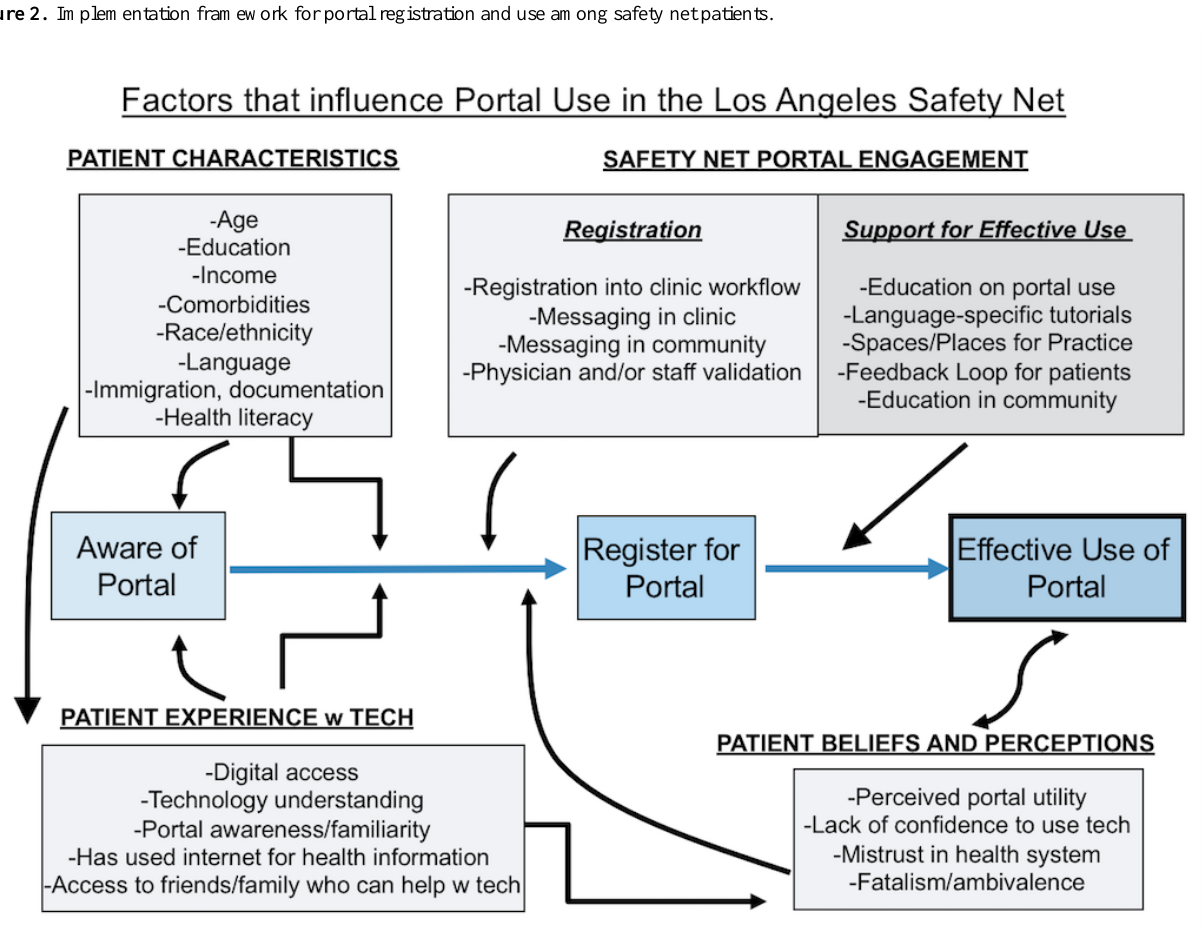
Figure 2. Implementation framework for portal registration and use among safety net